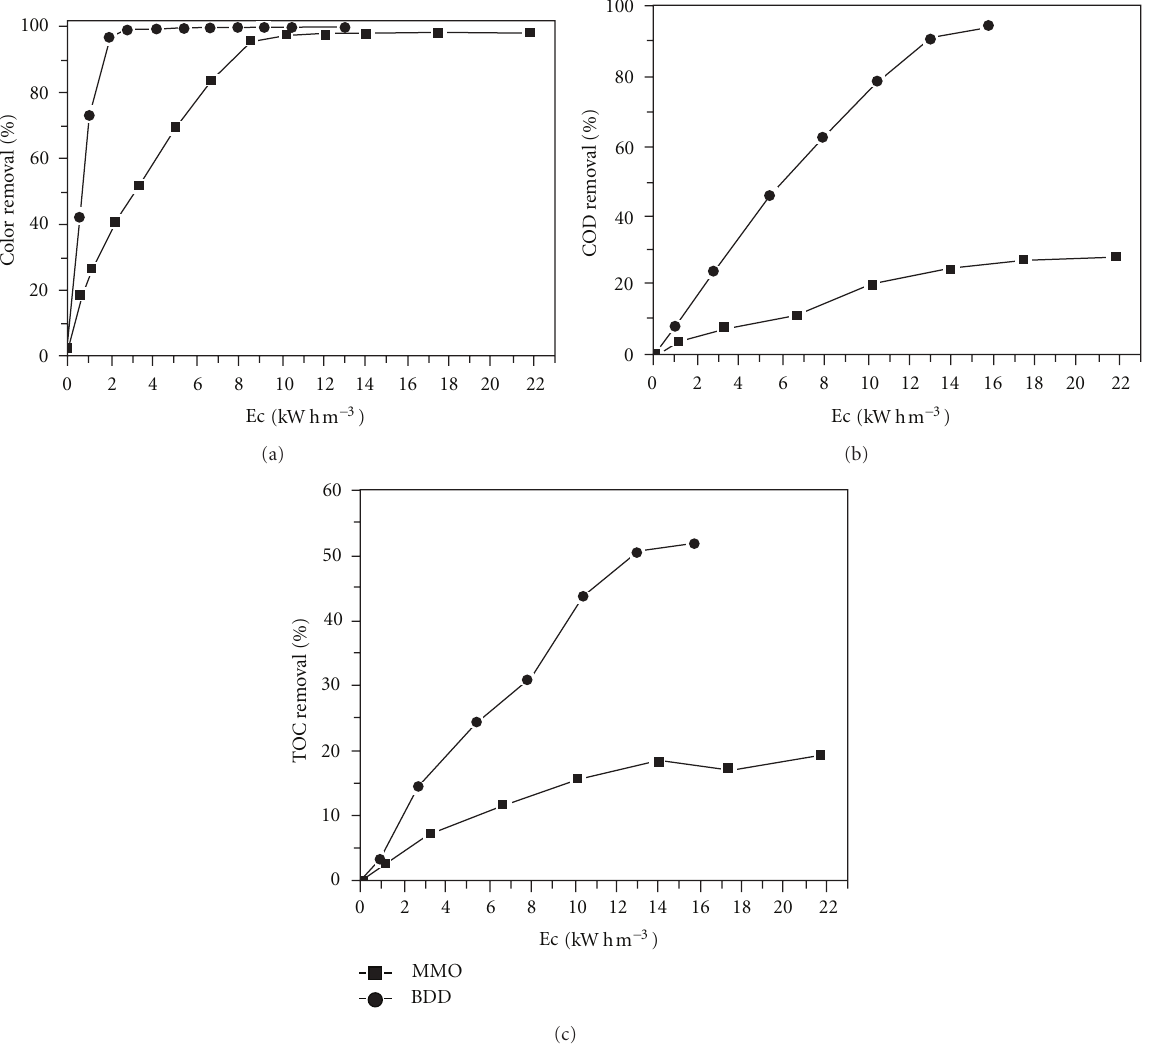
Figure 9: The removal of color, COD, and TOC on two electrodes. Conditions: electrolyte: Na 2 SO 4 0.1M + NaCl 0.05 M; pH 3; MO 200mgL − 1 ; current density: 50mAcm − 2 . Reprinted with permission of Separation and Purification Technology [39].